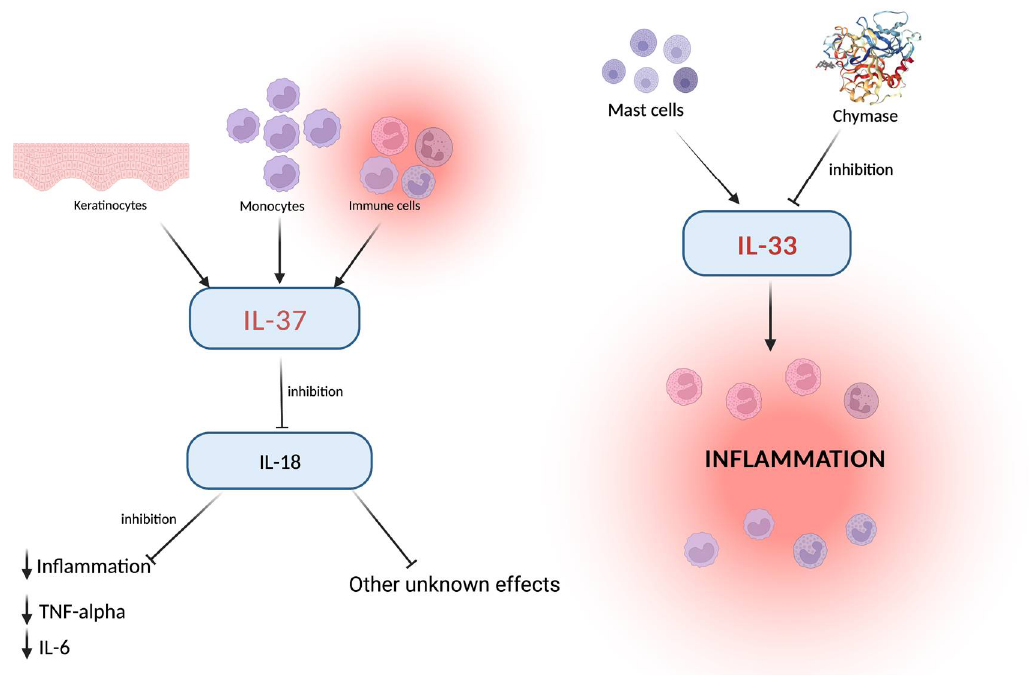
Figure 1. Keratinocytes, monocytes, and immune cells activate IL-37, which in turn downregulates IL-18 levels with consequent inhibition of inflammation and other effects which need further assessment. On the side, the IL-33 pro-inflammatory effect, played via the mast cells, explains the role of these cells around the blood vessels. The common link (the inflammation and related cells) represents the critical point in which other inflammation-related cytokines exert their role. Created with BioRender.com.